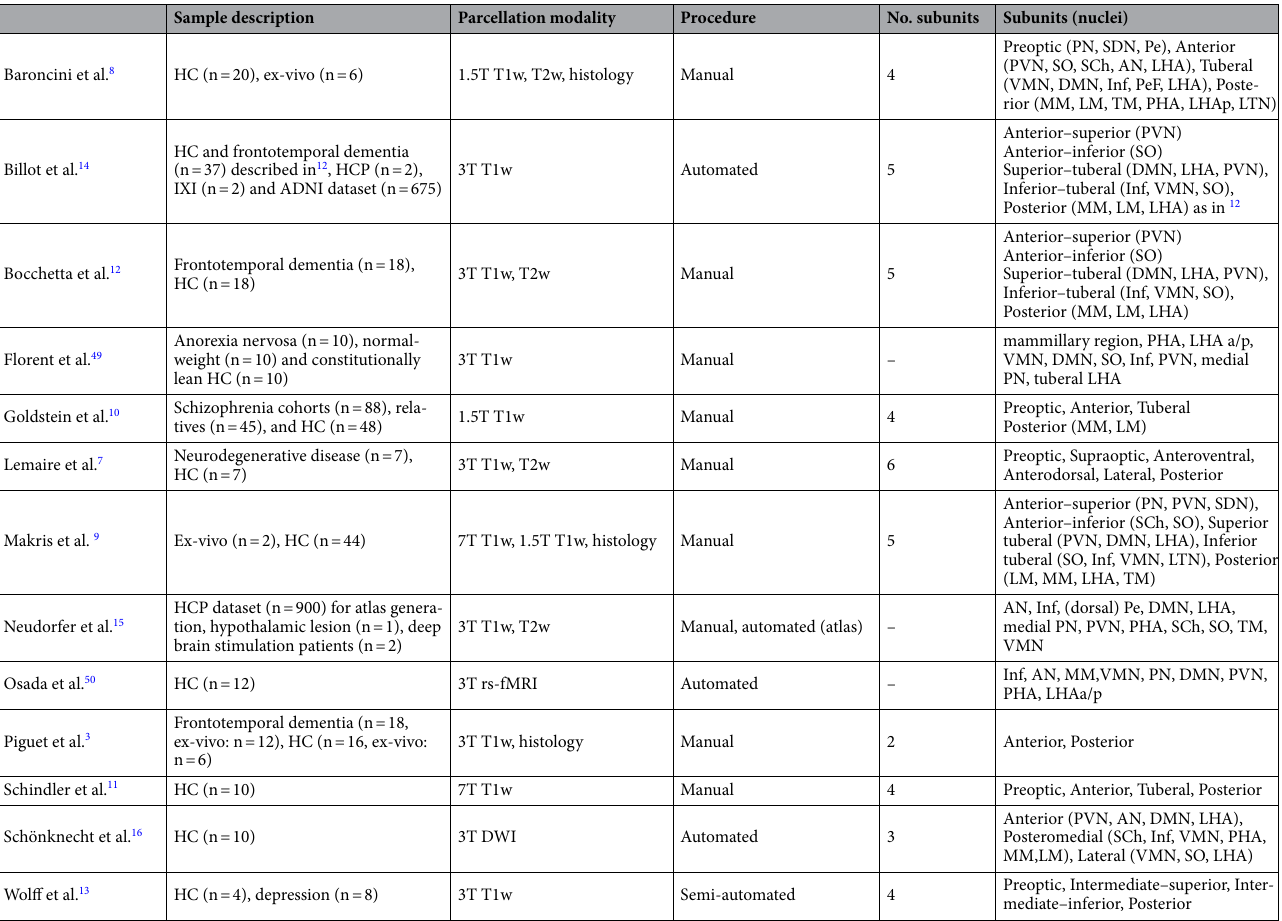
Table 1. Overview of studies including parcellation of the hypothalamus in humans using MRI and histology. When parcellation was performed on nucleus level, the number of subunits is denoted as –.